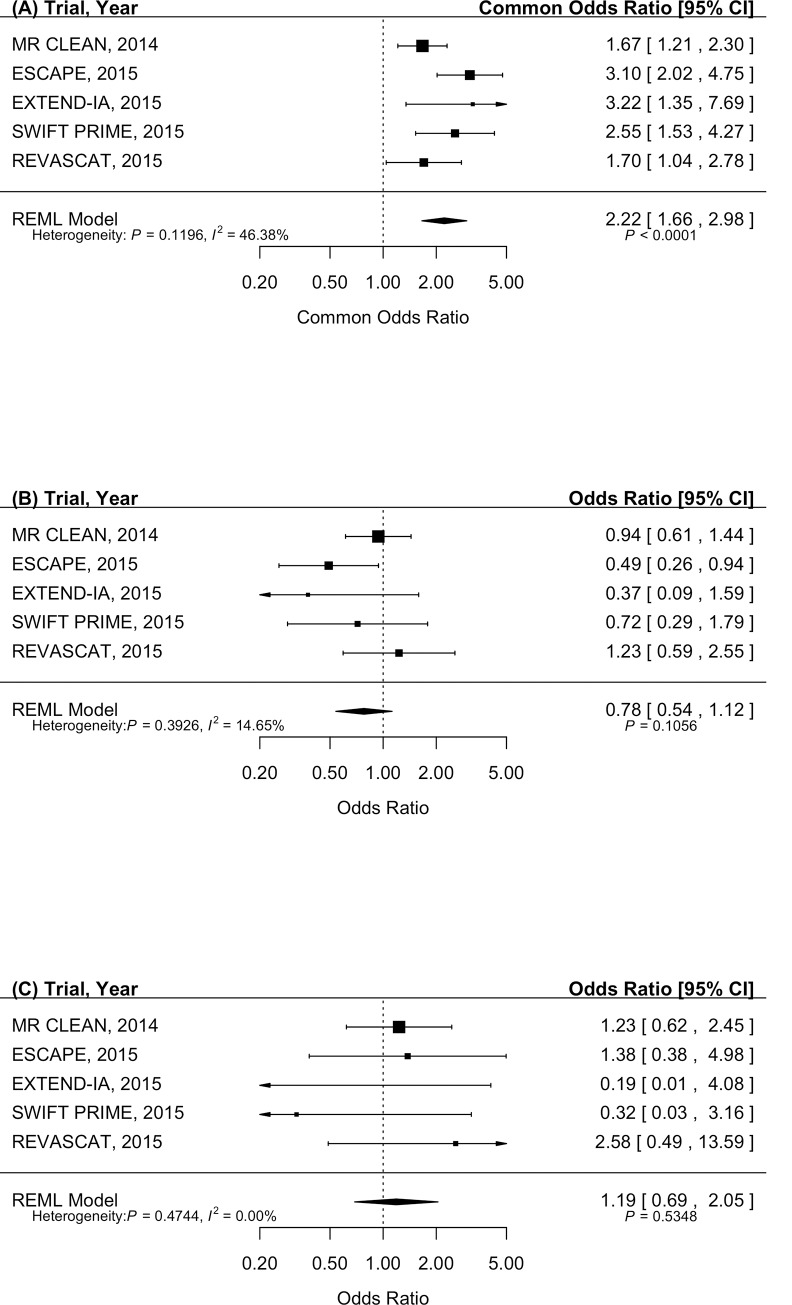
Pooled effect estimates by restricted maximum likelihood random effects model with inverse variance weighting.(A) Primary outcome of a shift in scores on modified Rankin Scale at 90 days between endovascular and medical management (common odds ratio, indicating odds of a more favorable distribution of scores on the modified Rankin Scale). (B) Secondary outcome of all-cause mortality (odds ratios). (C) Secondary outcome of symptomatic intra-cerebral hemorrhage (odds ratios).